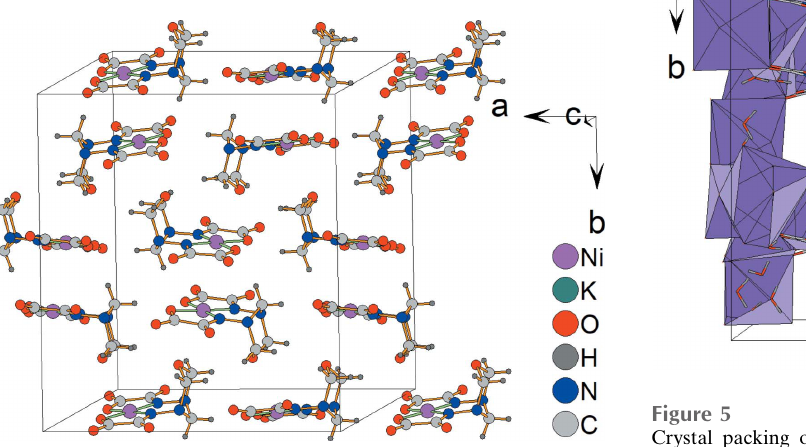
Figure 3 Layers formed by the anionic nickel(II) complexes.